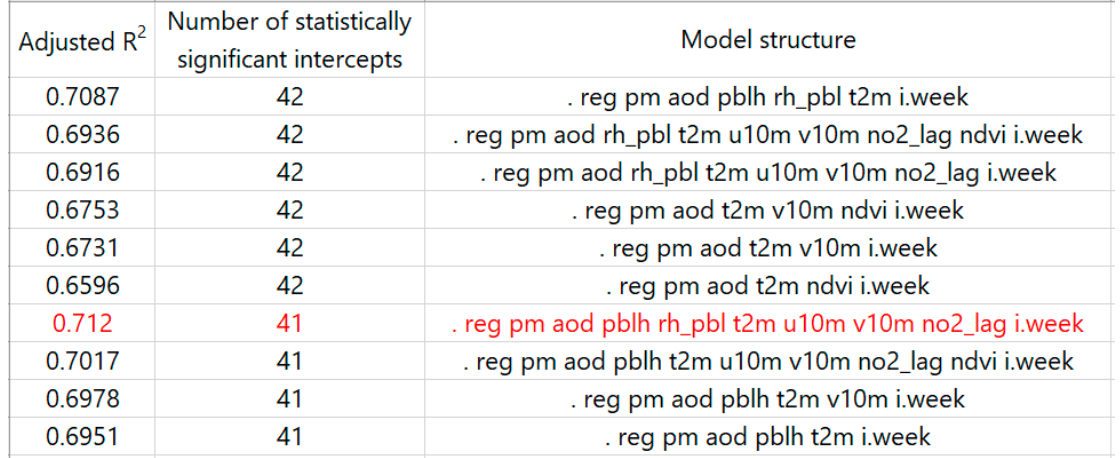
Figure A1. Screenshot of determining the best model structure for the TFER model with daily intercepts.